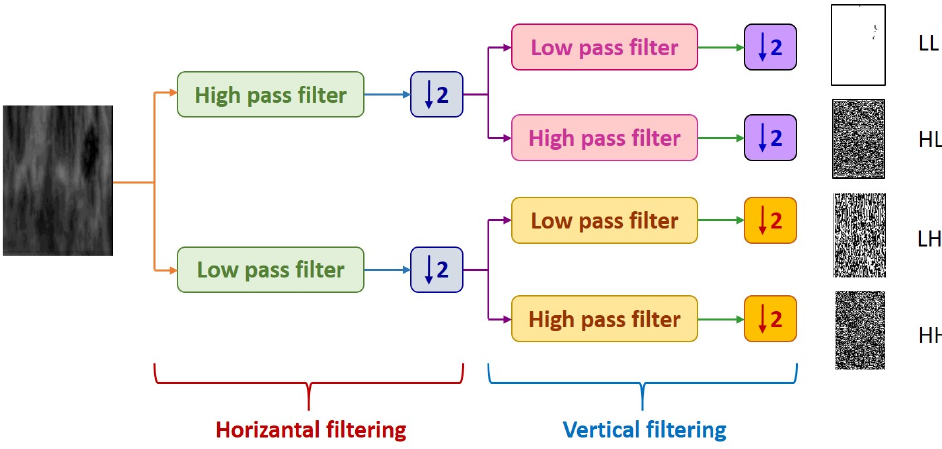
Figure 7. 1-Level DWT